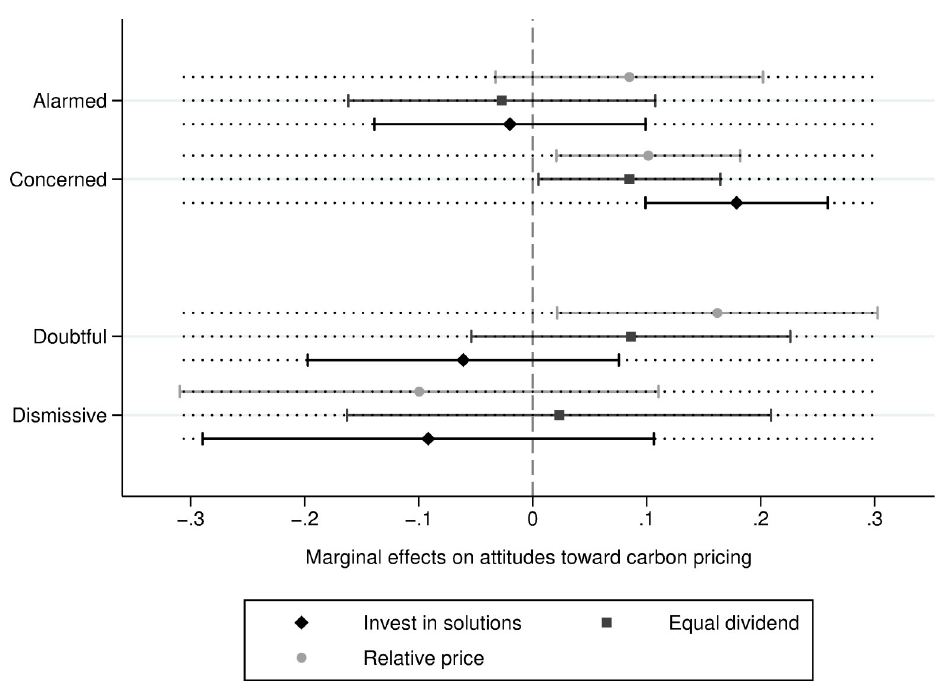
Fig 2. Marginal effect of emphasis framing on attitudes toward carbon pricing under high price specification, conditional on the Five Canadas (95% Cis).